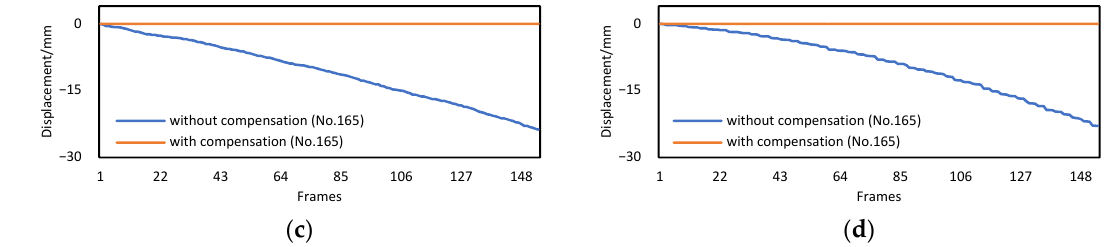
Figure 10. The measurement results obtained by the Scheimpflug camera without/with motion compensation. ( a ) Displacement results of camera translation in the x direction. ( b ) Displacement results of camera translation in the y direction. ( c ) Displacement results of camera rotation around the x -axis. ( d ) Displacement results of camera rotation around the y -axis.